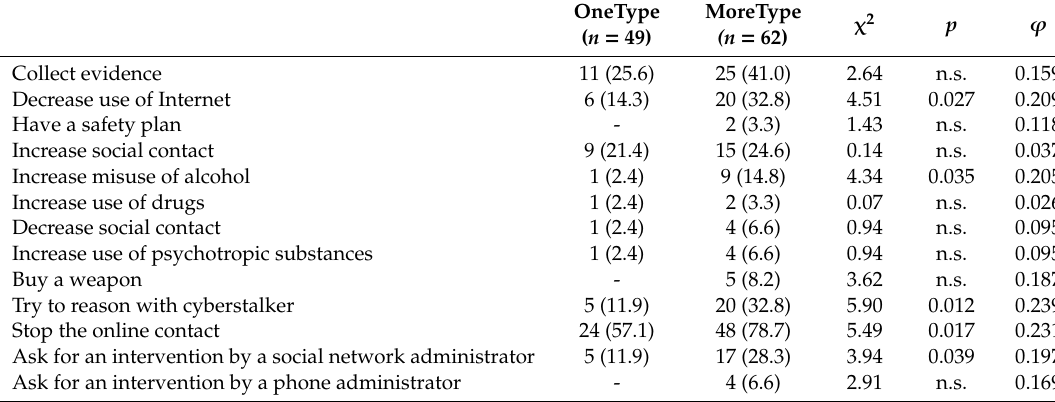
Table 3. Coping strategies: comparison between OneType and MoreType (percentage in